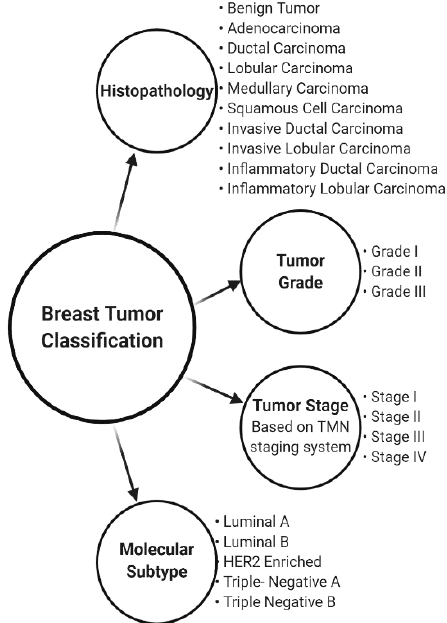
Figure 1. Schematic representation of the breast cancer classification depending on histopathological characteristics, tumor grade, tumor stage, and molecular subtype.